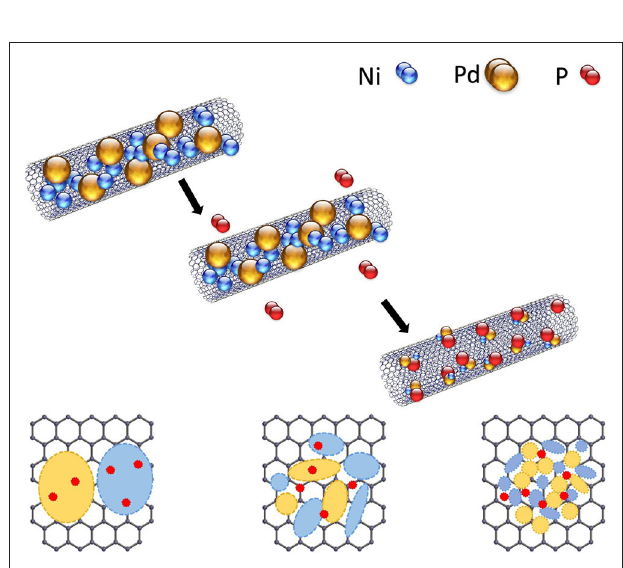
FIGURE 2 | Schematic of reduction and size reduction of catalyst particles by P addition.